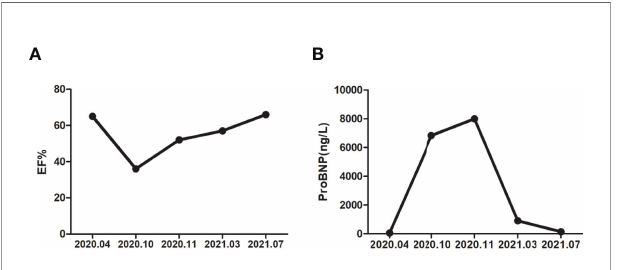
FIGURE 4 | The detection of cardiac function in different time periods. (A) Ejection fraction in different time periods. (B) Brain natriuretic peptide precursor (pro-BNP) in different time periods.